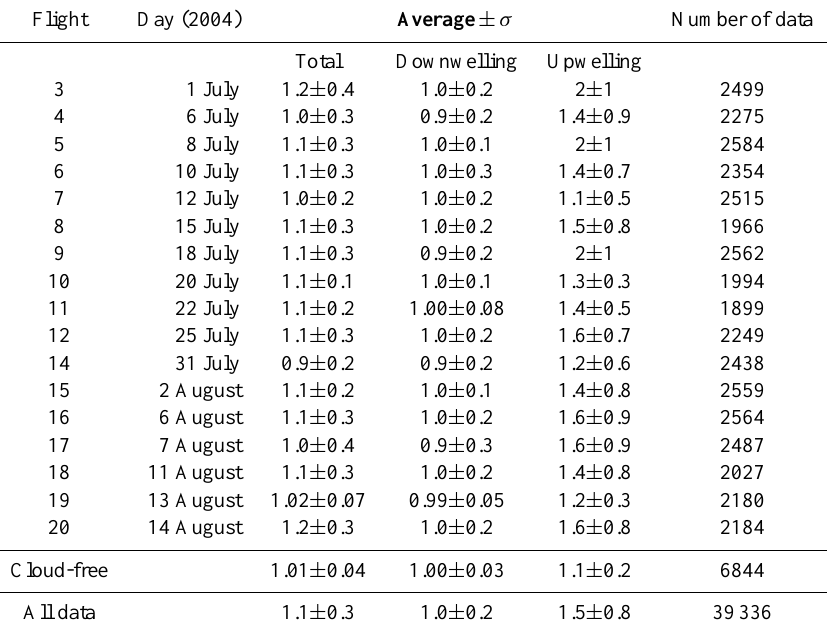
Table 1. Average ratios of the integrated actinic fluxes (298–422nm) measured to those calculated with the cloud-free model, for all INTEX- NA